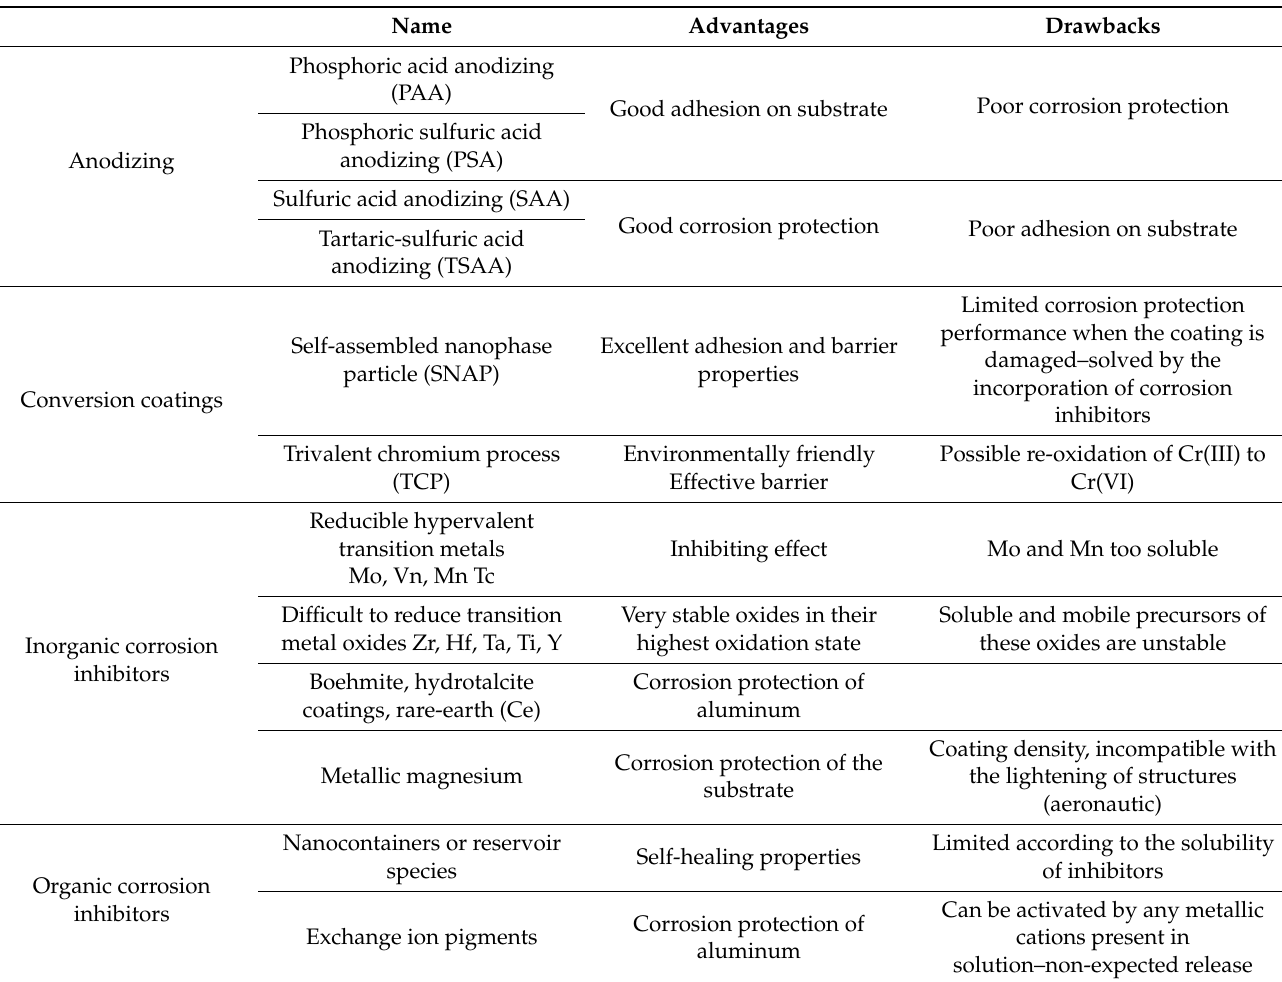
Table 1. Advantages and drawbacks of the different alternatives to Cr(VI) cited in this